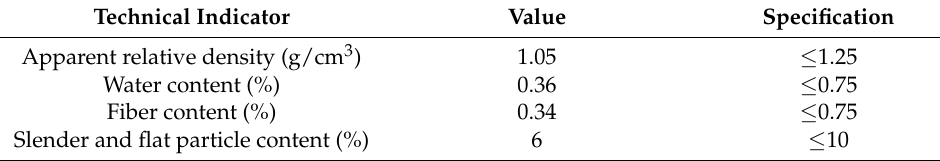
Table 2. Technical indicators of RP.